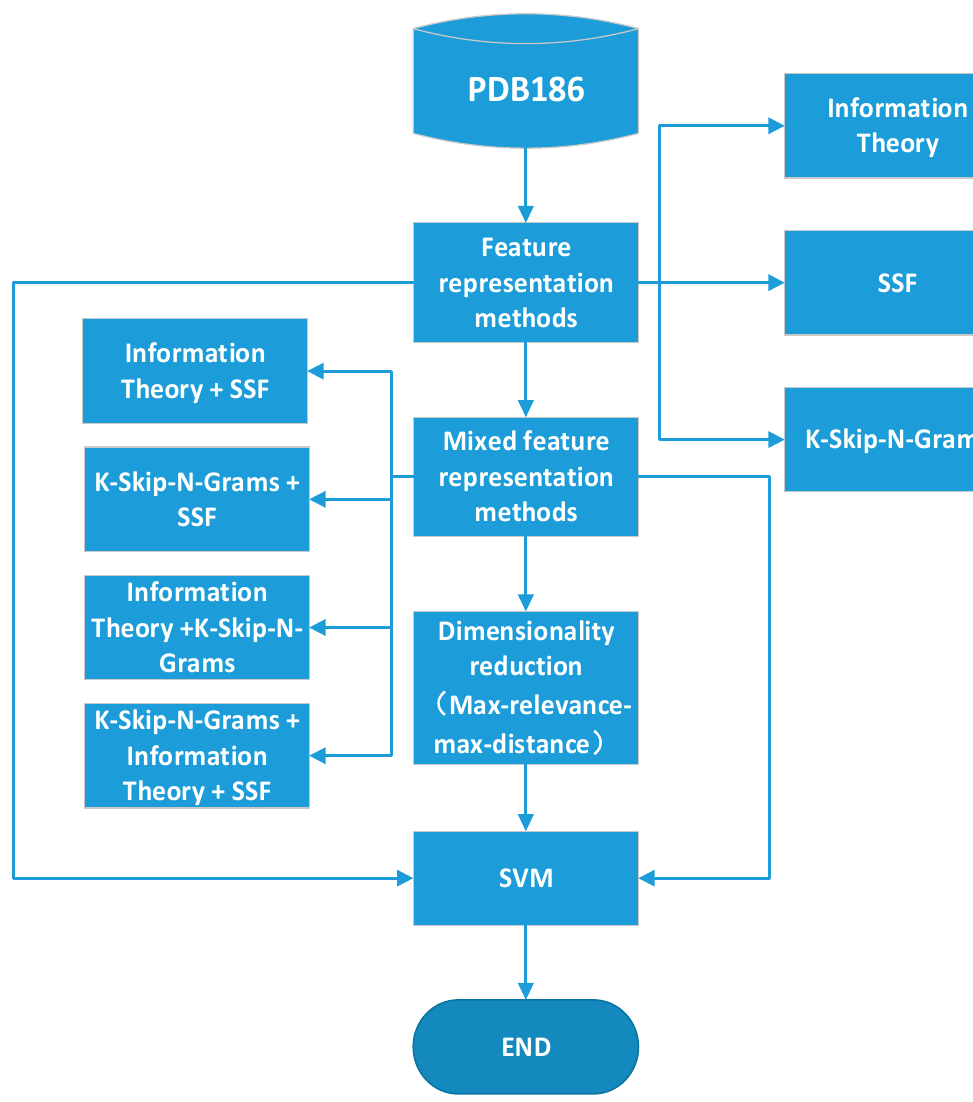
Figure 1. Overview of the paper framework for a DNA-binding protein classifier. First, the protein sequences are represented by Information Theory, SSF, and K-Skip-N-Grams. Then, three methods are combined. Finally, max-relevance-max-distance (MRMD) is used to reduce the dimensions. The support vector machine is used to classify the features which generated by the above three steps, respectively.